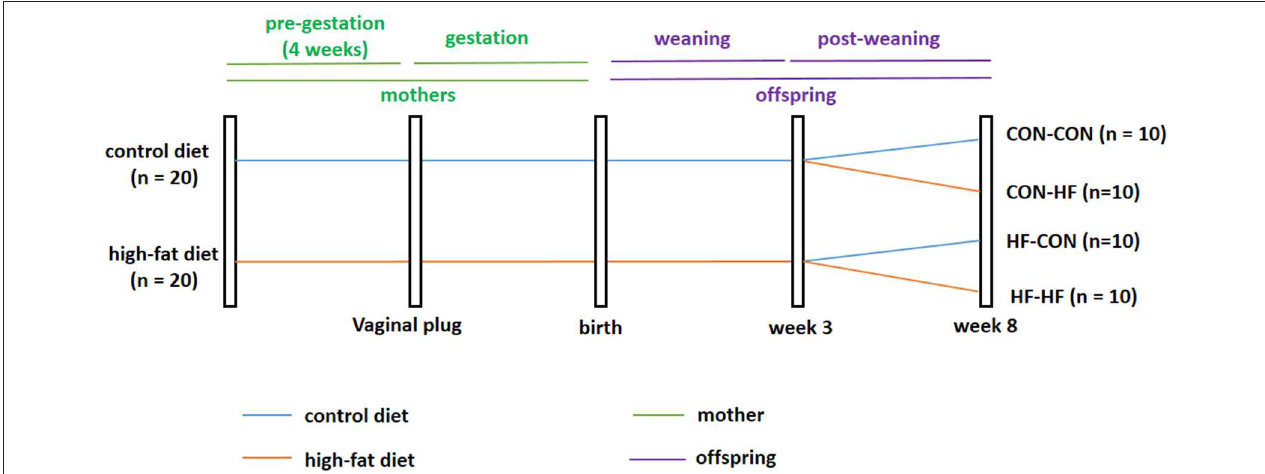
FIGURE 1 | Timeline of animal experiment. CON-CON: control diet mother-post-weaning control diet; CON-HF, control diet mother-post-weaning high-fat diet; HF-CON, high-fat diet mother-post-weaning control diet; HF-HF, high-fat diet mother-post-weaning high-fat diet.